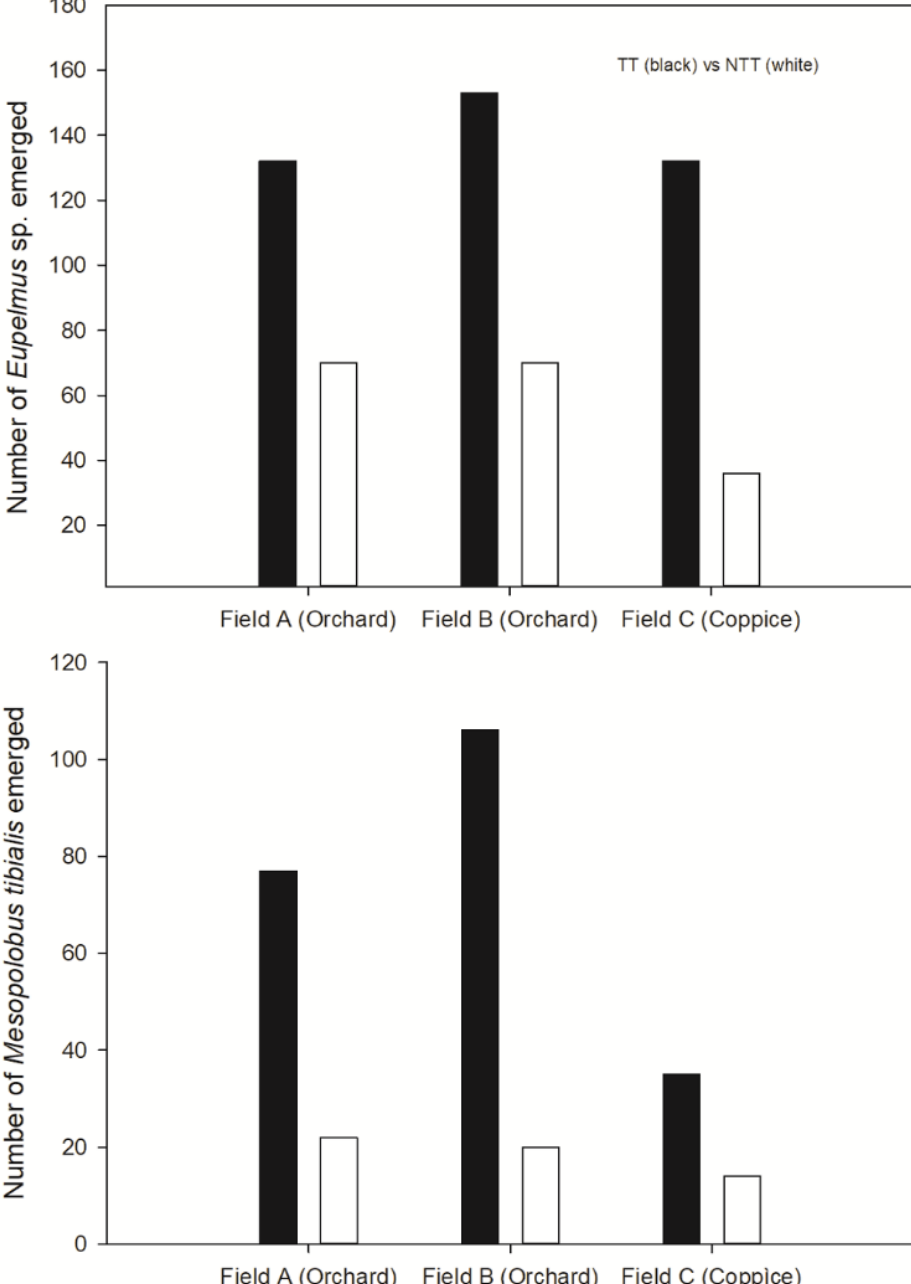
Figure 4. Eupelmus spp. and Mesopolobus tibialis emerged from cold-stressed (TT) and non-cold- stressed (NTT) galls collected from three chestnut fields. Data from the two years were